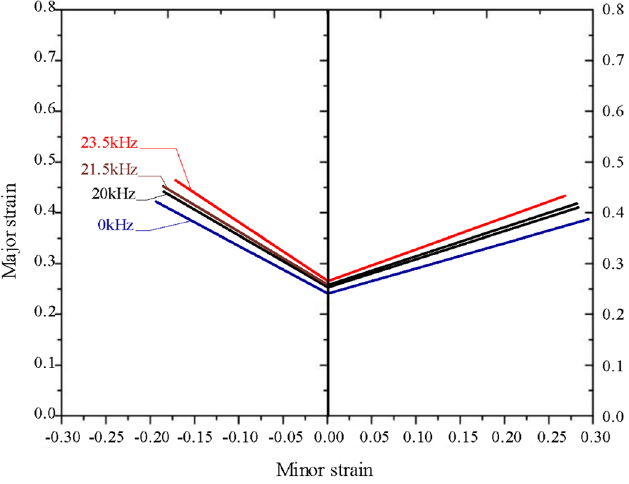
Fig. 12. Experimental FLDs based on ultrasonic